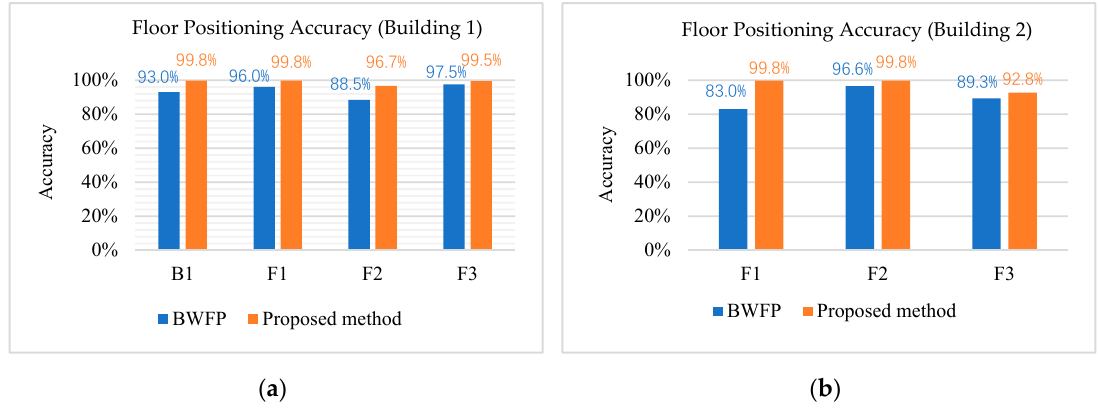
Figure 7. Floor positioning accuracy in ( a ) Building 1 and ( b ) Building 2.